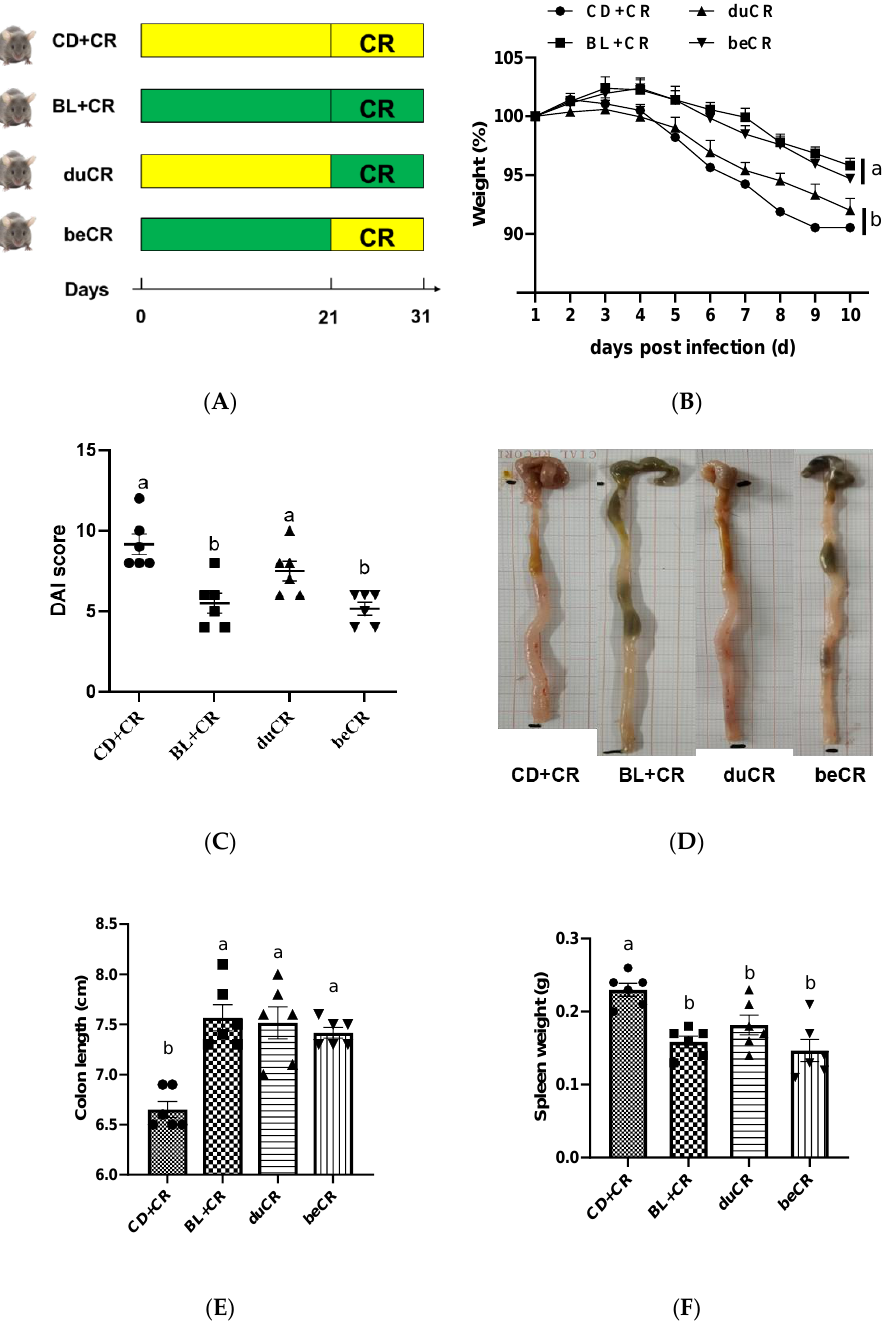
Figure 1. Effect of BL supplementation on mice before and during CR infestation. ( A ) Study design of mice grouping and treatment ( n = 6 per group). ( B ) Weight loss. ( C ) Disease activity index (DAI) scores. ( D ) Representative images showing the gross appearance of the intestinal tissues; ( E ) Colon length. ( F ) Spleen weight. The a, b means in the same bar without a common letter differ at p < 0.05. Transmissible murine colonic hyperplasia (TMCH) is the hallmark feature in CR-in- fected mice, exhibiting epithelial cell proliferation, colonic crypt hyperplasia, and mucosal thickening [14]. To investigate the effect of beCR and duCR on CR-induced intestinal